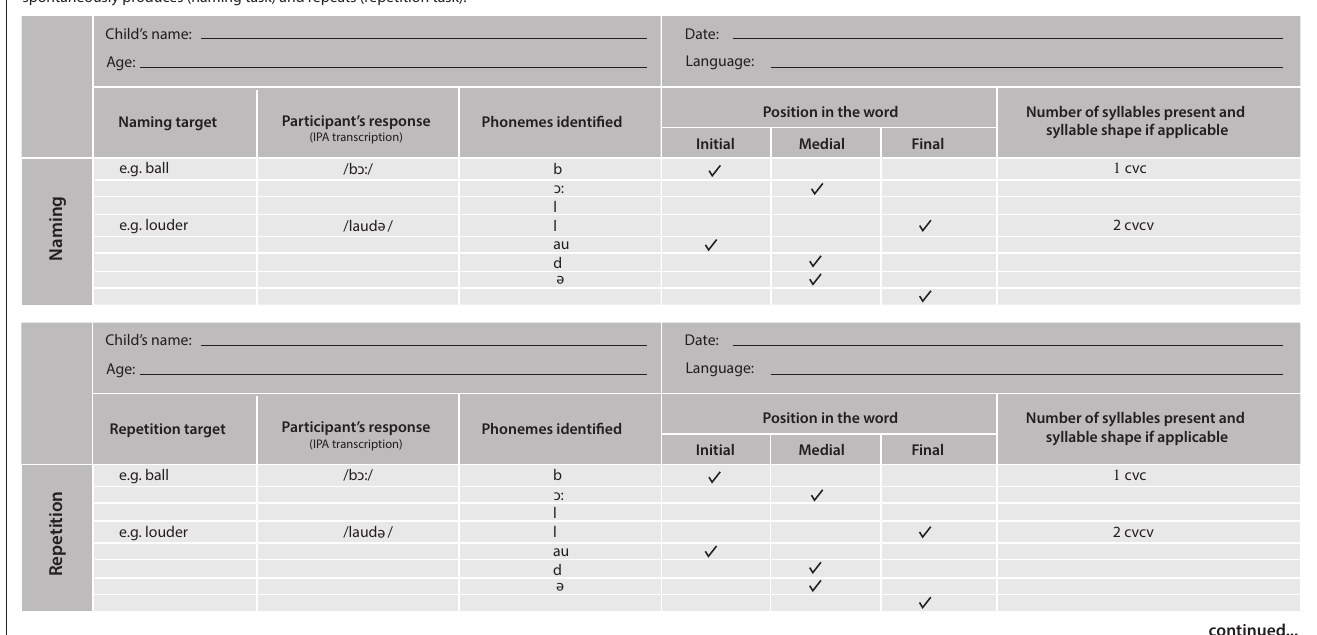
usePhonological processPercentage correct measures